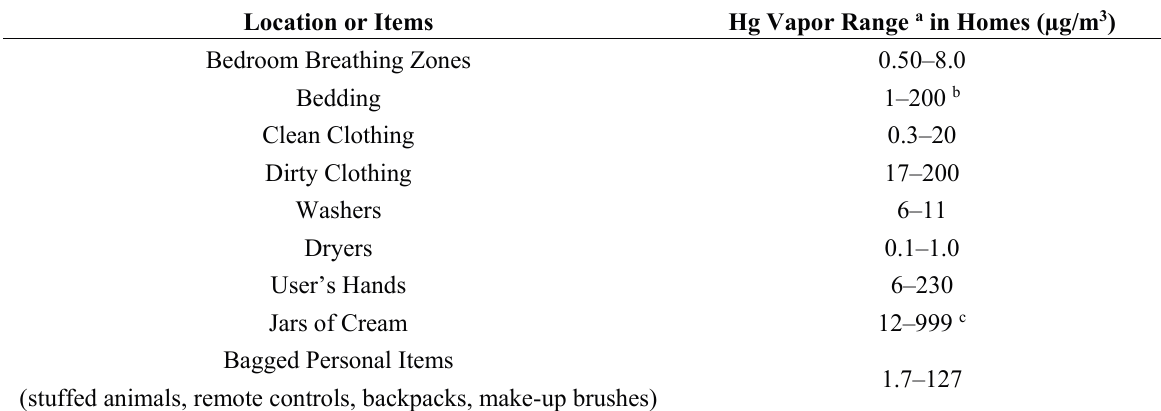
Table 4. Range of mercury vapor (Hg) levels in three